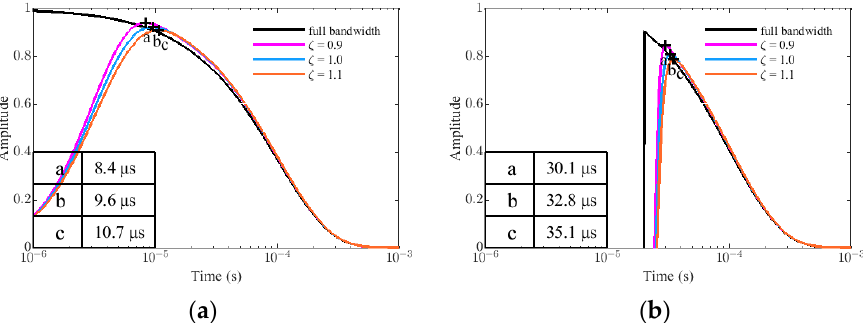
Figure 9. The simulation results in different damping coefficients ζ : ( a ) the target response of PRBS method G p (t). ( b ) the target response of traditional method G t (t).